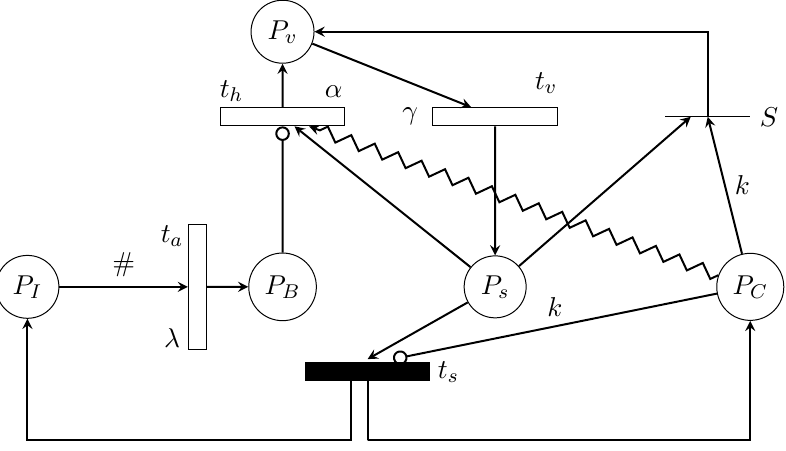
Figure 3: MRSPN representation of the M/G/ 1 /V The places P